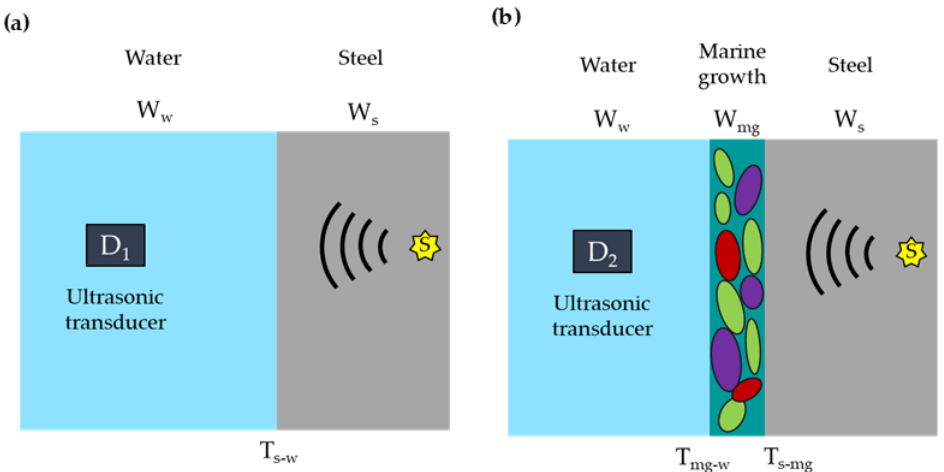
Figure 1. Schematic illustration of primary elastic wave propagating paths ( a ) without marine growth and ( b ) with marine growth.